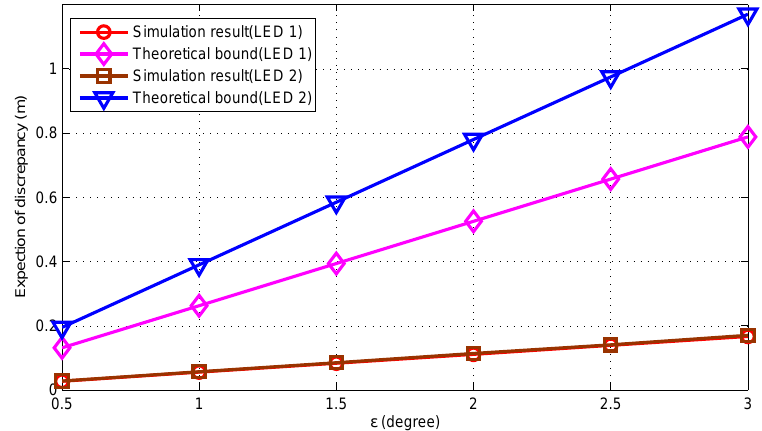
Figure 8. Performance analysis versus reference LED